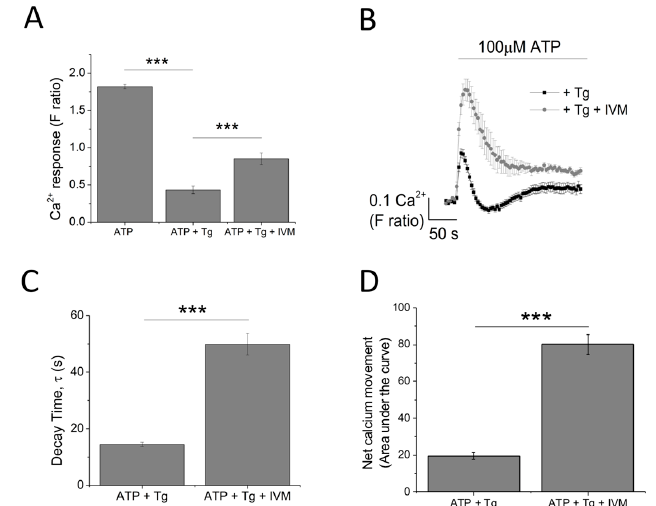
Figure 4. Investigating the contribution of P2X 4 receptor using the positive allosteric modulator ivermectin. ( A,B ) effect of 3 μ M IVM on Tg-resistant Ca 2+ response represented as bar chart and time- response curve, respectively ( n = 6). The effect of 3 μ M ivermectin (IVM) on: ( C ) decay kinetics ( n = 6) and ( D ) net calcium movement as quantified by area under the curve ( n = 6) of THP-1 differentiated macrophages. Asterisks include significant changes towards control (*** p < 0.001).